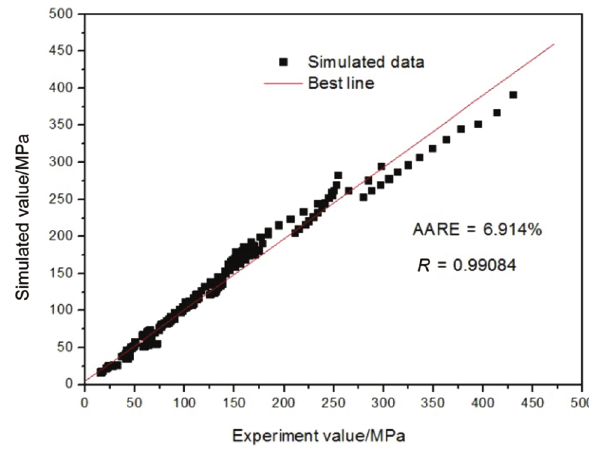
Figure 12: Comparison of the predicted data obtained from the Arrhenius-type constitutive model (taking the compensation of strain into account) and experimentally determined data.